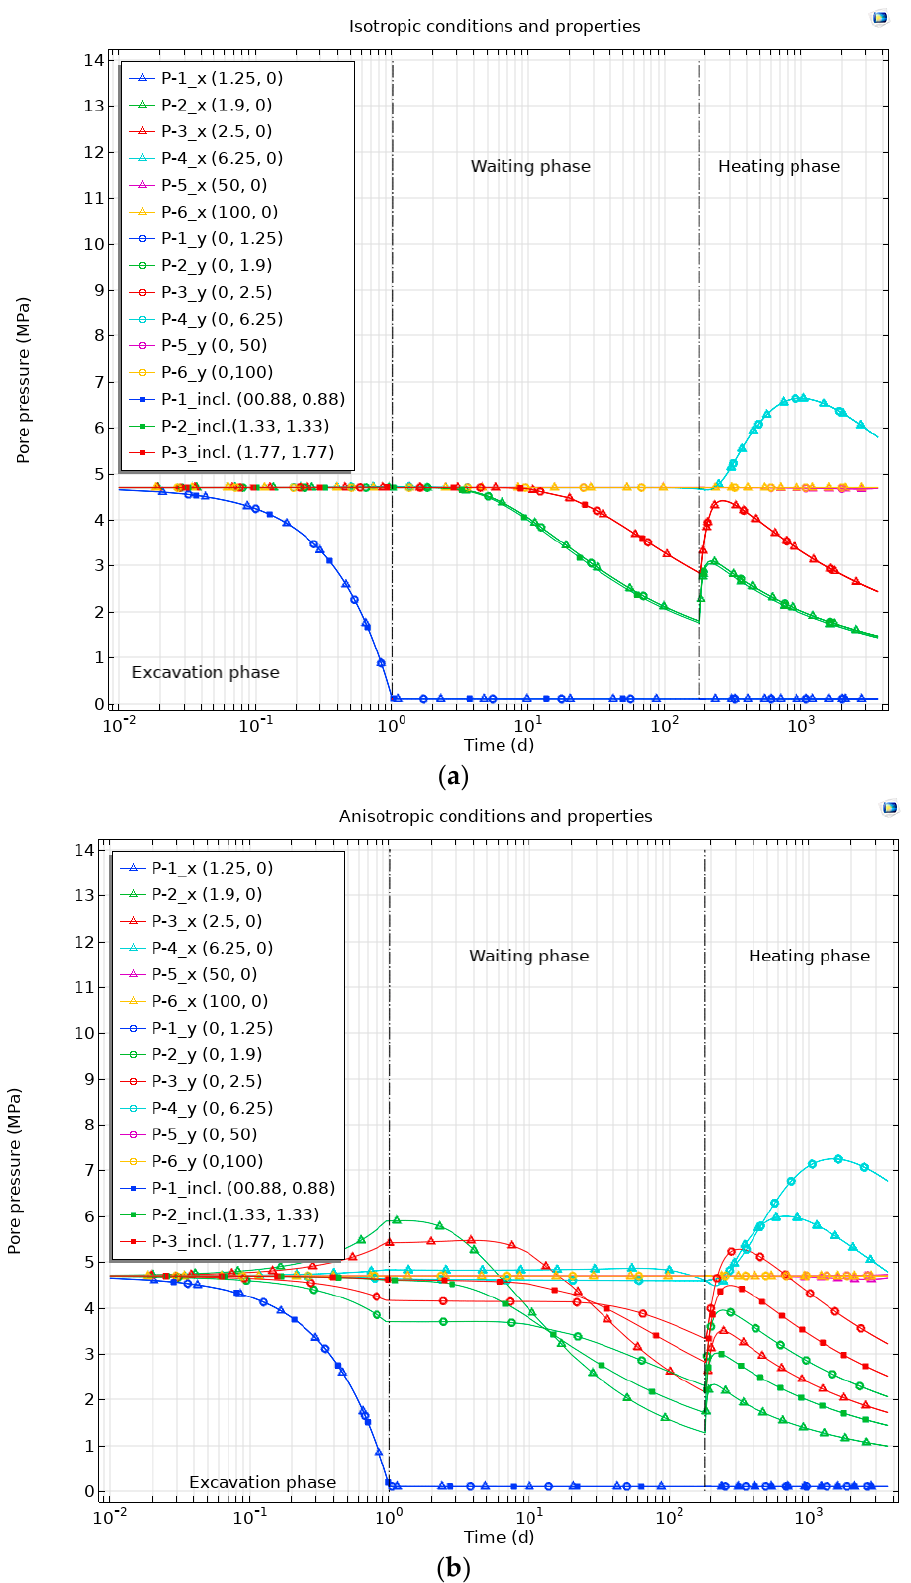
Figure 7. DC variant: evolution of pore pressure at selected points: ( a ) isotropic stress conditions and isotropic properties, ( b ) anisotropic stress conditions and anisotropic properties.